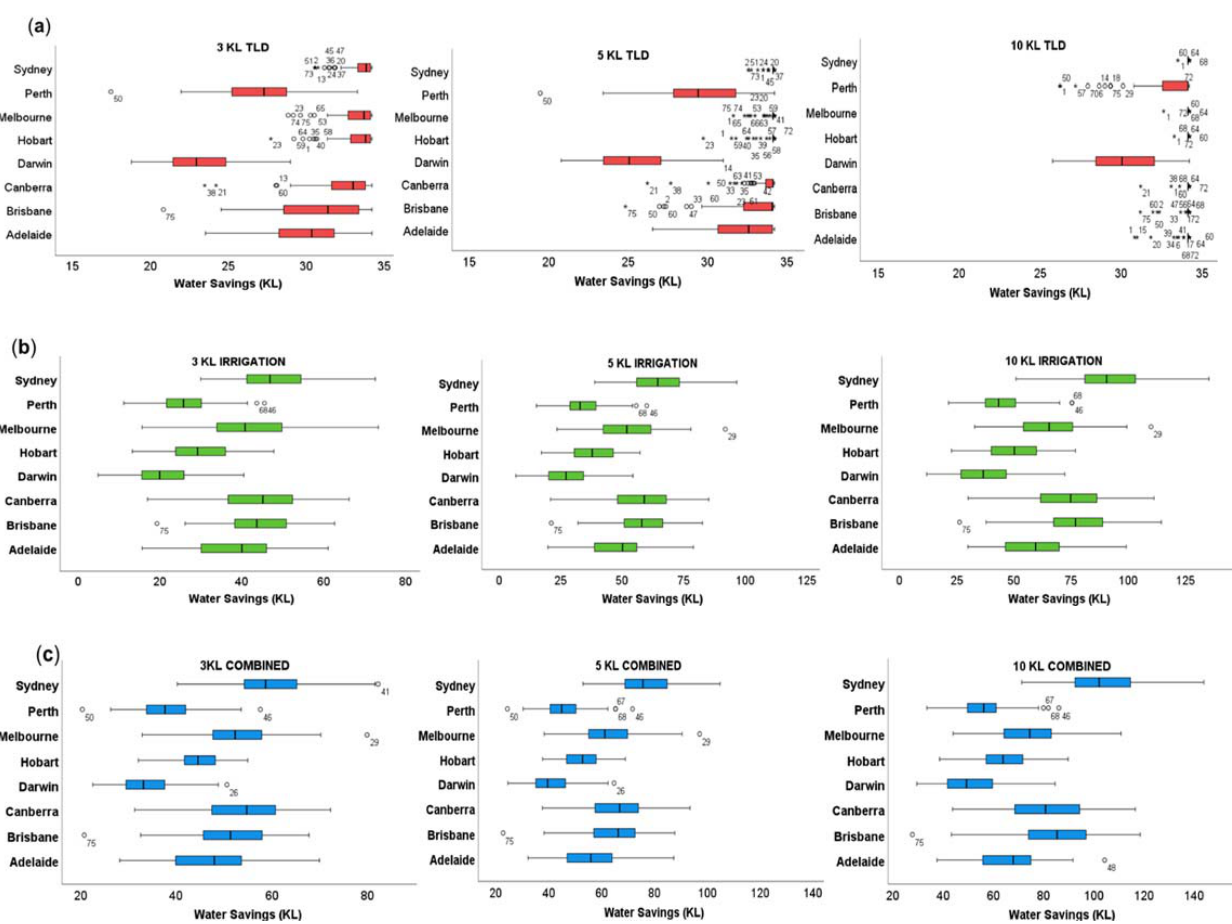
Figure 7. Boxplot showing distribution of annual water savings for: ( a ) TLD use; ( b ) irrigation use; ( c ) combined use for eight different cities for 3, 5 and 10 m 3 rainwater tanks.